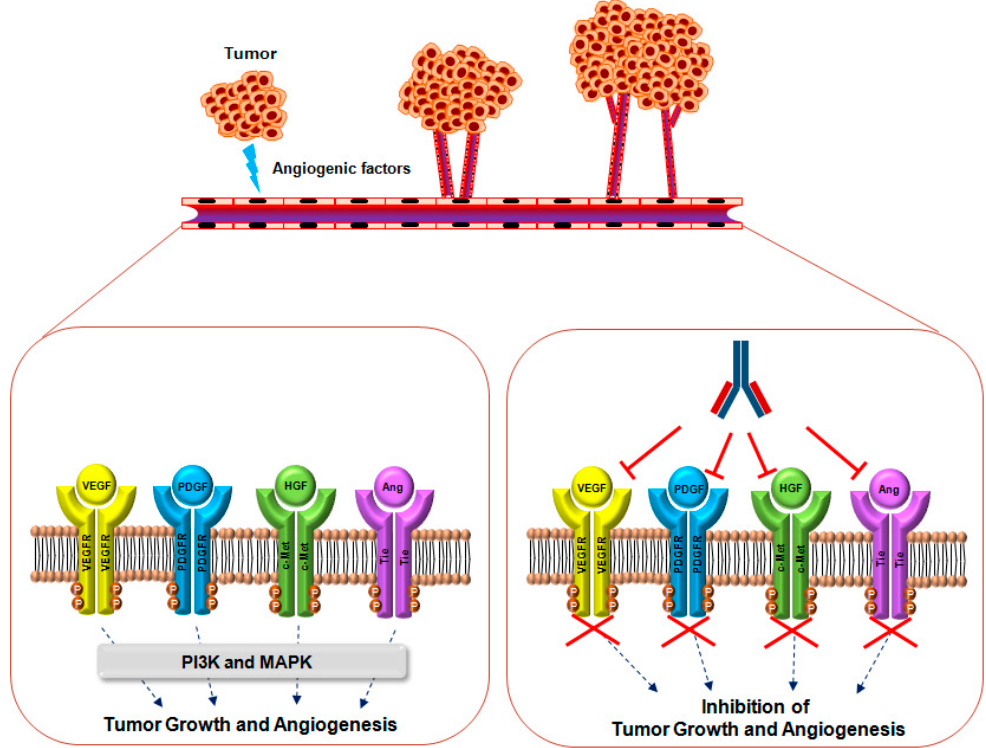
Figure 1. Mechanisms of action of monoclonal antibodies targeting VEGF, PDGF, HGF, Ang, and their receptors for suppressing tumor growth and angiogenesis. Under pathological conditions, including hypoxia, most tumor cells and/or adjacent cells upregulate the expression of many angiogenic factors, including VEGF, PDGF, HGF, and Ang, and secrete them within the tumor microenvironment. When these molecules bind their cognate receptors, receptor dimerization and autophosphorylation stimulate downstream signaling molecules including phosphatidylinositol-4,5-bisphosphate 3-kinase (PI3K)/v-Akt murine thymoma viral oncogene (Akt) and MAPK (dash lines) for the promotion of tumor growth and angiogenesis. Currently, most antibody therapeutics are being developed to block the interaction between agonists and their receptors (T arrows).